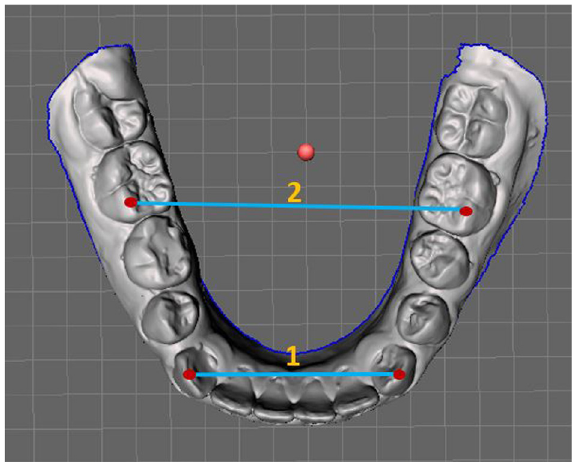
Figure 6. (1) Intercanine width, (2) intermolar